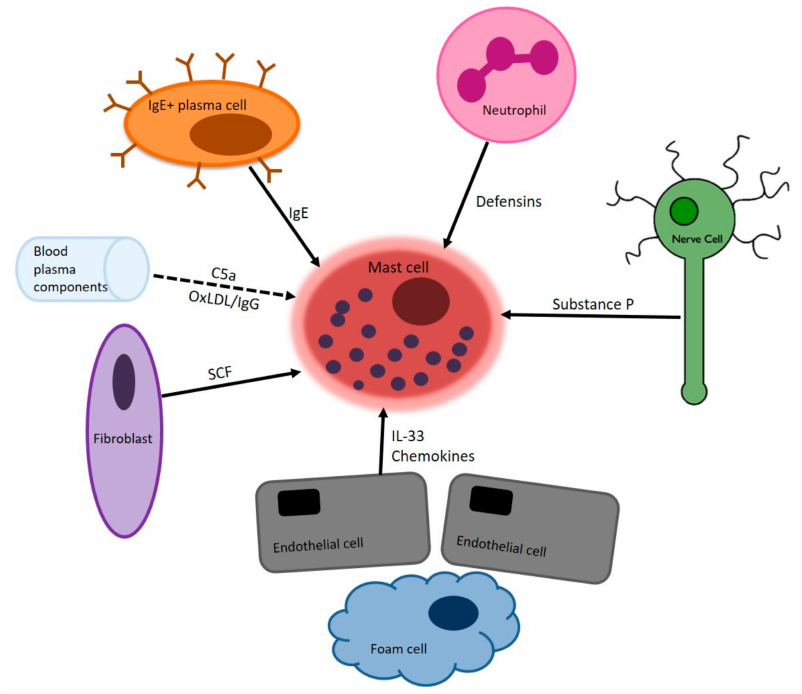
Figure 1. The mast cell is activated by various signals that arise from cells that are present in and around the atherosclerotic plaque. The mast cell is a tissue resident cell, and can adjust its actions according to stimuli from its environment. Here, the most important cells in the vascular wall and the atherosclerotic plaque are depicted. Each cell can deliver a di ff erent stimulus to cause mast cell activation. Subsequently, the activated mast cell produces di ff erent mediators which further enhance local inflammation and plaque instability (see Figure 2). SCF: Stem cell factor, C5a: Complement factor 5a, OxLDL / IgG: Oxidated LDL / IgG complexes (where LDL refers to low density